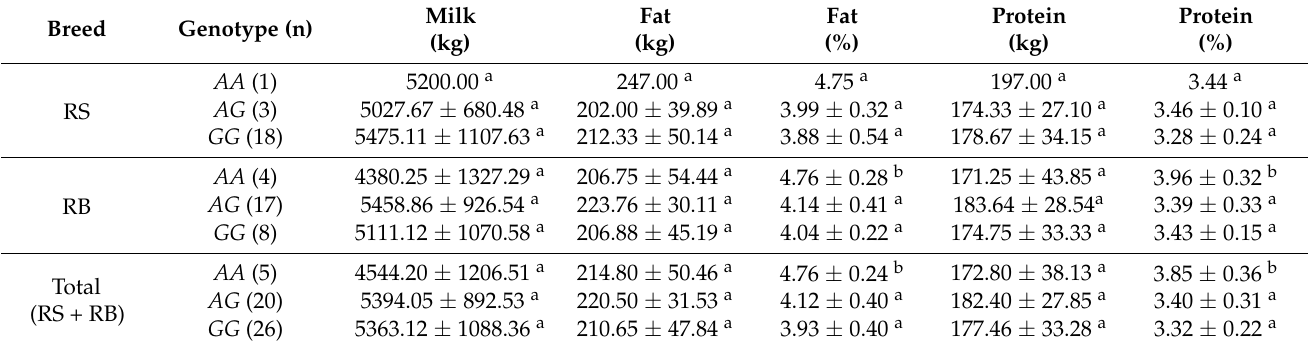
Table 4. Mean ± standard deviation (SD) for milk production and chemical composition traits based on the genotypes of the PRL locus in Romanian Spotted (RS) and Romanian Brown (RB) cattle breeds. Milk Fat Fat Breed Genotype (n) (kg) (kg) (%)